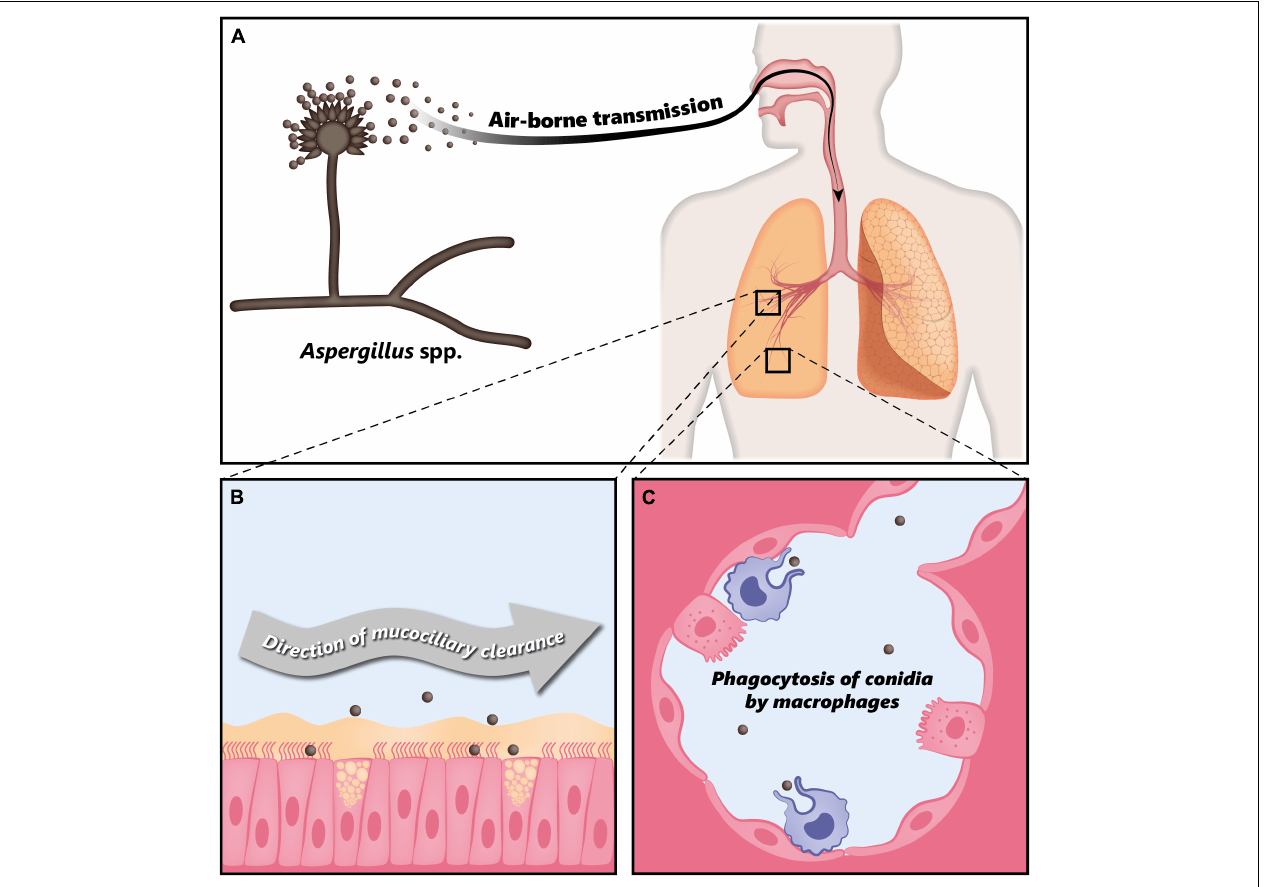
FIGURE 1 | Clearance of Aspergillus conidia in the immunocompetent host. (A) Aspergillus spp. conidia are transmitted through air and every individual inhales thousands of conidia every day. (B) In the immunocompetent host, most of the inhaled conidia are trapped by the mucus layer secreted by the tracheal and bronchial epithelium, and are efficiently eliminated through mucociliary clearance. (C) Due to their small size, conidia can eventually reach the alveoli, where they are phagocytosed by alveolar macrophages. Modified from Palmieri